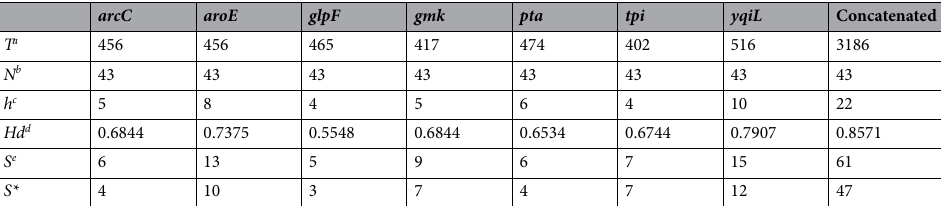
Table 1. Molecular diversity indices of wide populations by multilocus sequence typing genes of Staphylococcus aureus . T a : length of DNA sequences (pb); N b : number of sequences; h c : number of haplotypes; Hd d : haplotypic diversity; S e : polymorphic sites; S * number of parsimony informational sites.